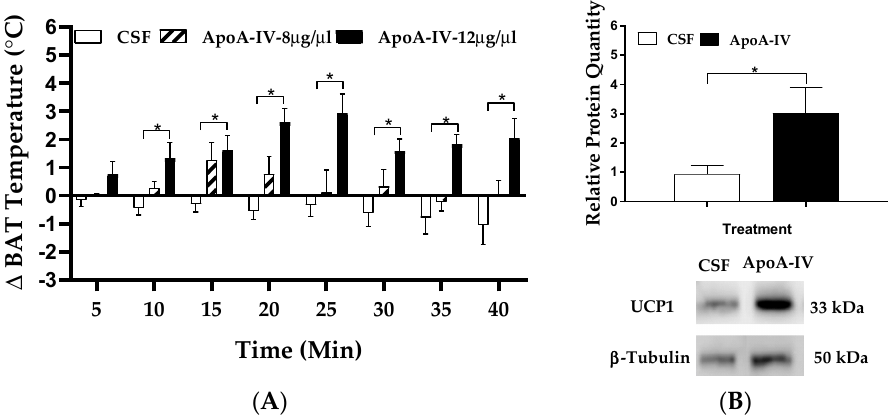
Figure 1. The effects of ApoA-IV on BAT temperature and UCP1 protein levels. BAT temperature was measured every 5 min for up to 40 min in mice following administration of either ApoA-IV at two different doses or CSF ( A ). The mice received central administration of either CSF (1 µL) or ApoA-IV (12 µg) into the third ventricle, and BAT was collected at 40 min post-injection. UCP1 protein in BAT was measured by immunoblot analysis ( B ). Data are expressed as the means ± SEM for 7–8 mice per group. * Represents a significant difference relative to the corresponding CSF-treated BAT ( p < 0.5). Compared to CSF treatments, ApoA-IV significantly increased gene expression levels of Ampk α 1 , Hsl , Cpt1 , Ucp1 , and Ucp3 in BAT ( p < 0.05, Figure 2A–D). No significant differences in Ampk α 2 and Atgl expression levels in BAT were observed between the CSF- and ApoA-IV-treated groups (Figure 2A,B).